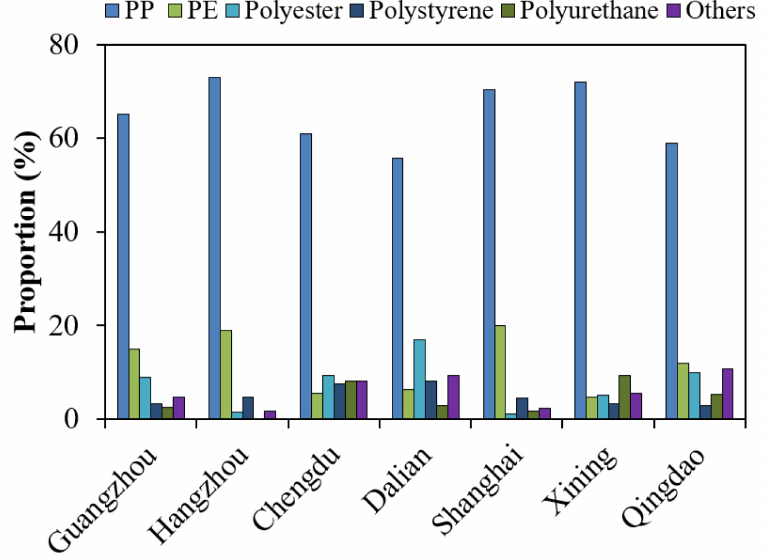
Figure 4. Polymer composition of MPs in takeout food containers collected from different cities in China. “Others” means other polymer compositions of MPs, mainly including polyethylene chlori- nated, polyamide, polycarbonate, and polyethylene terephthalate. PP and PE indicate polypropylene and polyethylene, respectively.